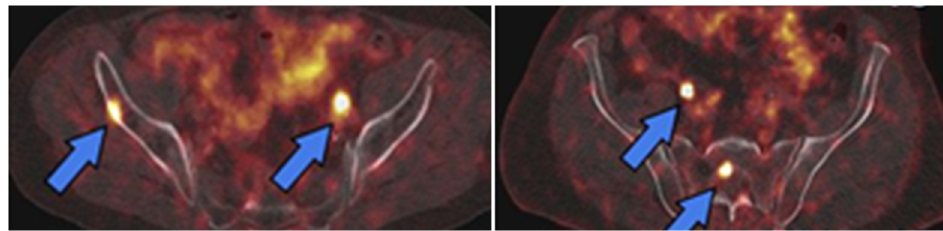
Figure 6. PET images of PSMA expression in PCa (blue arrows) using [ 68 Ga]Ga-PSMA-11 (left image) and [ 18 F]DCFPyL (right image). This research was originally published in the Journal of Nuclear Medicine (JNM) [61].